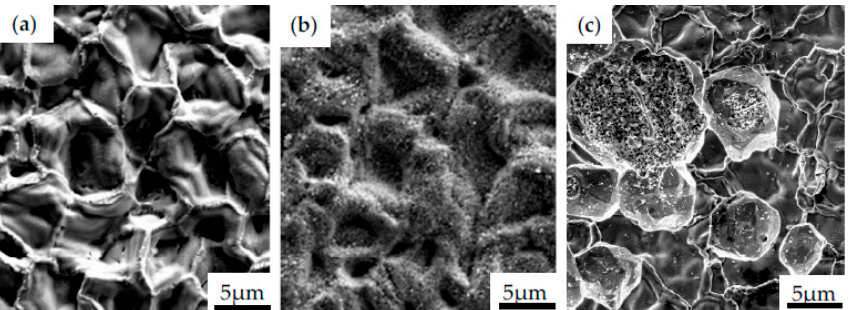
Figure 8. The images of morphology of MAR247 with NiAl coating obtained during CVD process in the as-received state ( a ), after high temperature corrosion test at 1000 °C for 100 h ( b ), and after corrosion test in 0.3 M NaCl solution ( c ).